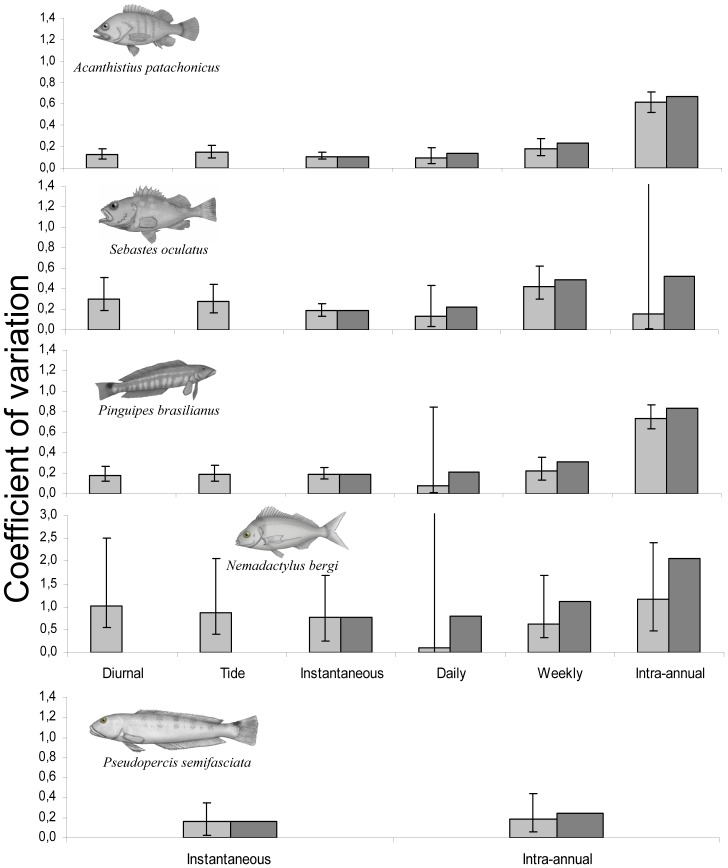
Temporal components of variability in counts.Coefficients of variation associated with different factors and temporal scales of variability in fish counts, estimated using mixed- and random-effect models fitted to census data for five reef-fish species. Soft grey bars represent the component of variation contributed by each temporal scale (with 95% confidence intervals) and darker grey bars represent the total (cumulative) variation of counts at each temporal scale. Note the different scale of the y-axis for Nemadactylus bergi.